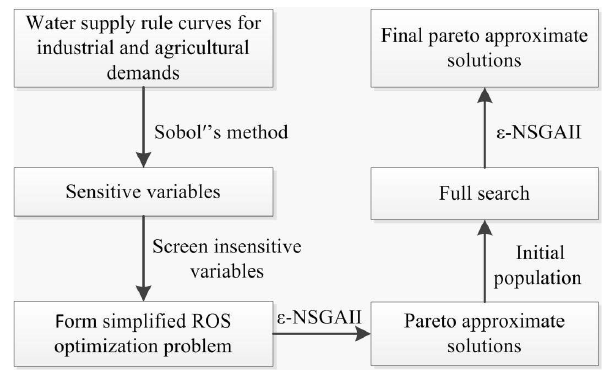
Figure 2. Flowchart of the sensitivity-informed